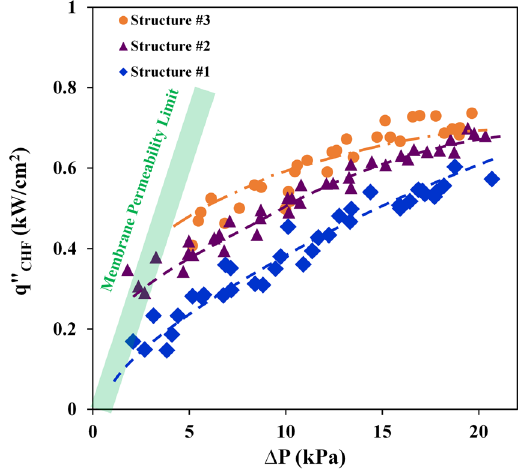
Figure 5. CHF as a function of applied liquid pressure.